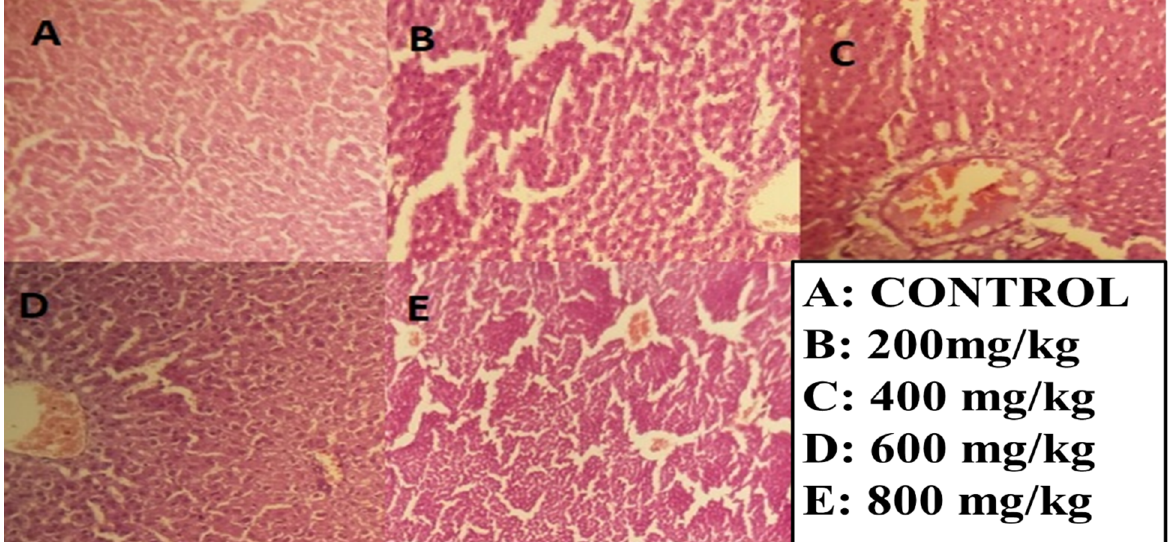
Figure 10. Hepatotoxicity histopathology investigations of the liver section given the n -butanol fraction ( A ) No ballooning of cells and no fibrosis ( B ) Slightly ballooning of hepatocytes and no accumulation of ECM ( C ) Overall, the liver tissue seems healthy ( D ) Slightly ballooning, accumulation of ECM was observed, nuclear variation ( E ) no vacuolar degeneration, and fatty droplets are present.